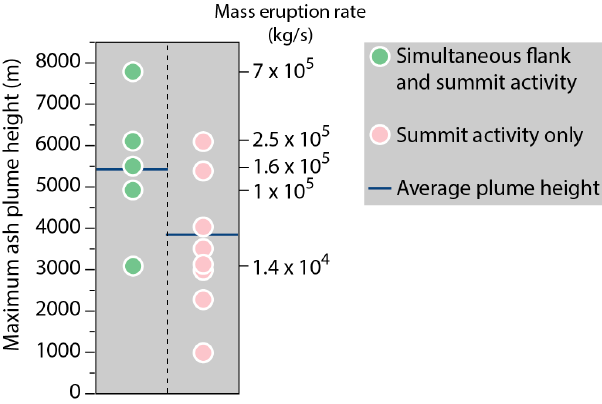
Figure 5: Maximum ash-cloud height (above sea level), mass eruption rate and location of historical eruptive ac- tivity at cone A of Veniaminof Volcano. Historical erup- tions with simultaneous summit and flank activity pro- duced slightly higher rising ash clouds that could have been a consequence of the partitioning of more gas- charged magma into the vertical conduit of a T-junction type conduit system. Mass eruption rates estimated us- ing method described in Mastin